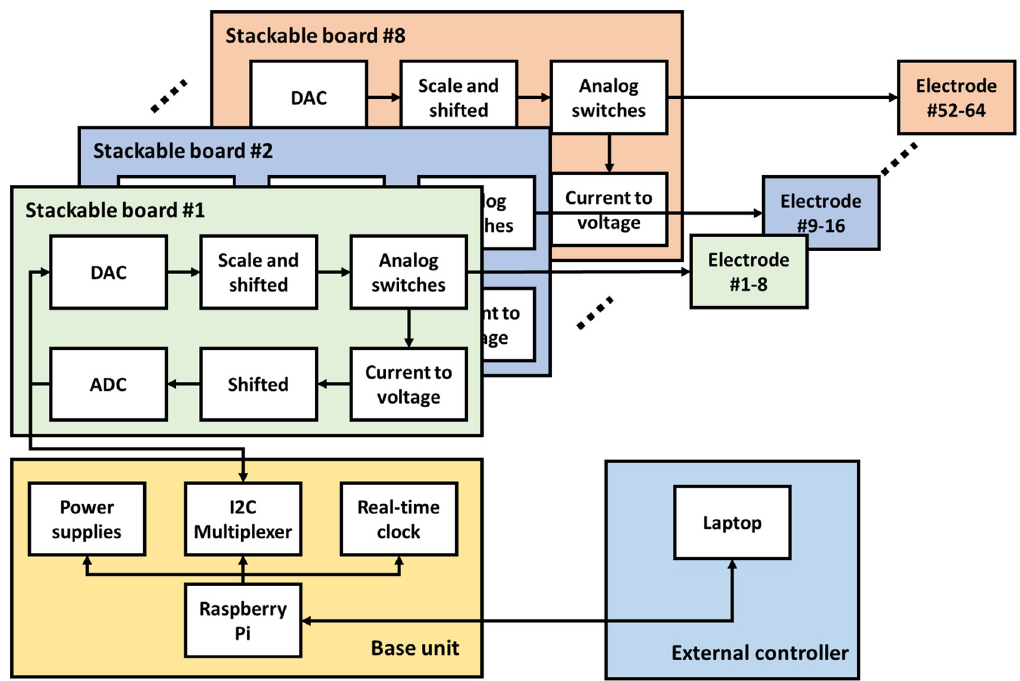
Fig 4. The multi-channel potentiostat block diagram. The multi-channel potentiostat consists of a base unit and stackable boards. The base unit receives commands from a laptop and provides power and communication to the stackable boards. Each stackable board contains eight independent channels. The multi-channel potentiostat design allows up to eight stackable boards installed simultaneously, resulting in a total of 64 channels. A computer can interface with the multi-channel potentiostat via Ethernet or